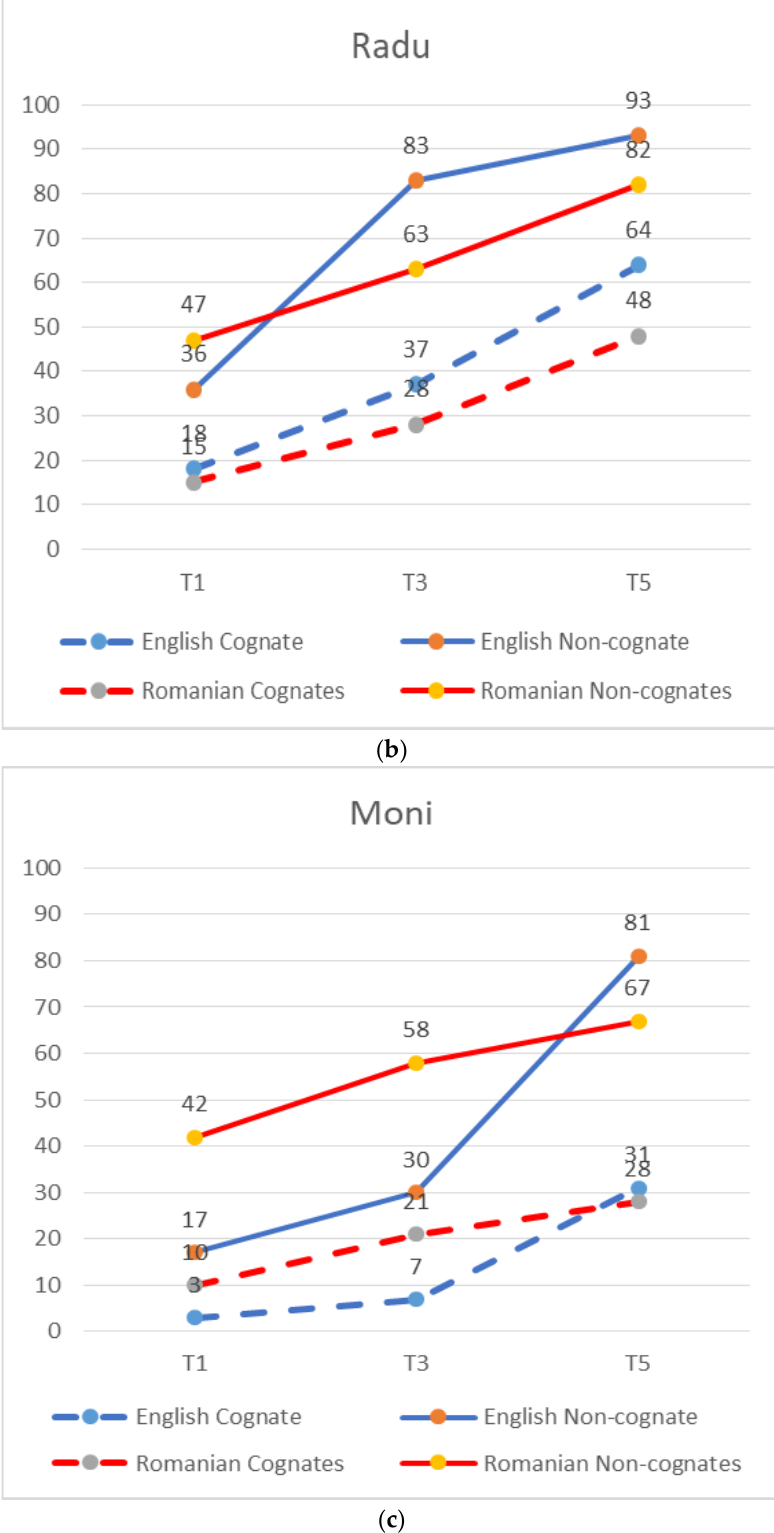
Table 3 analyzes the means and standard deviations in the four categories mentioned above: home versus academic and cognate versus non-cognate. As explained in Section 2.4, as there is